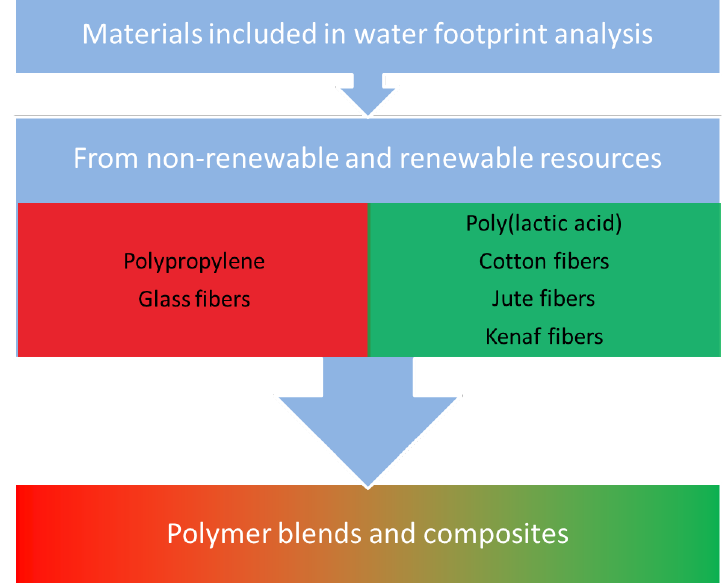
Figure 3. Materials included in water footprint analysis.